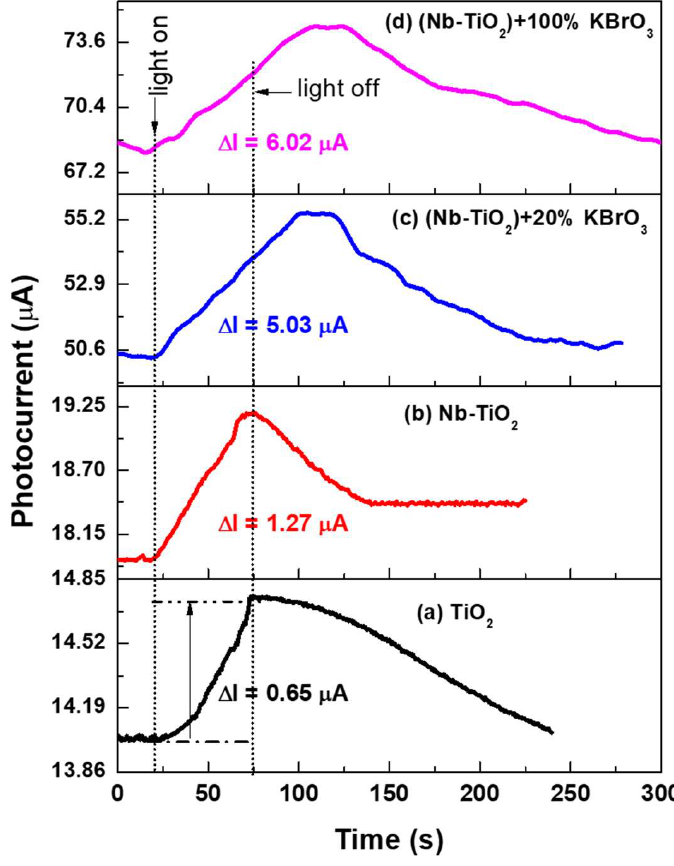
Figure 9. The photocurrent obtained at a bias voltage of 0.2 V for pure TiO 2 , Nb-TiO 2 , Nb- TiO 2 /20%KBrO 3, and Nb-TiO 2 /100%KBrO 3 .